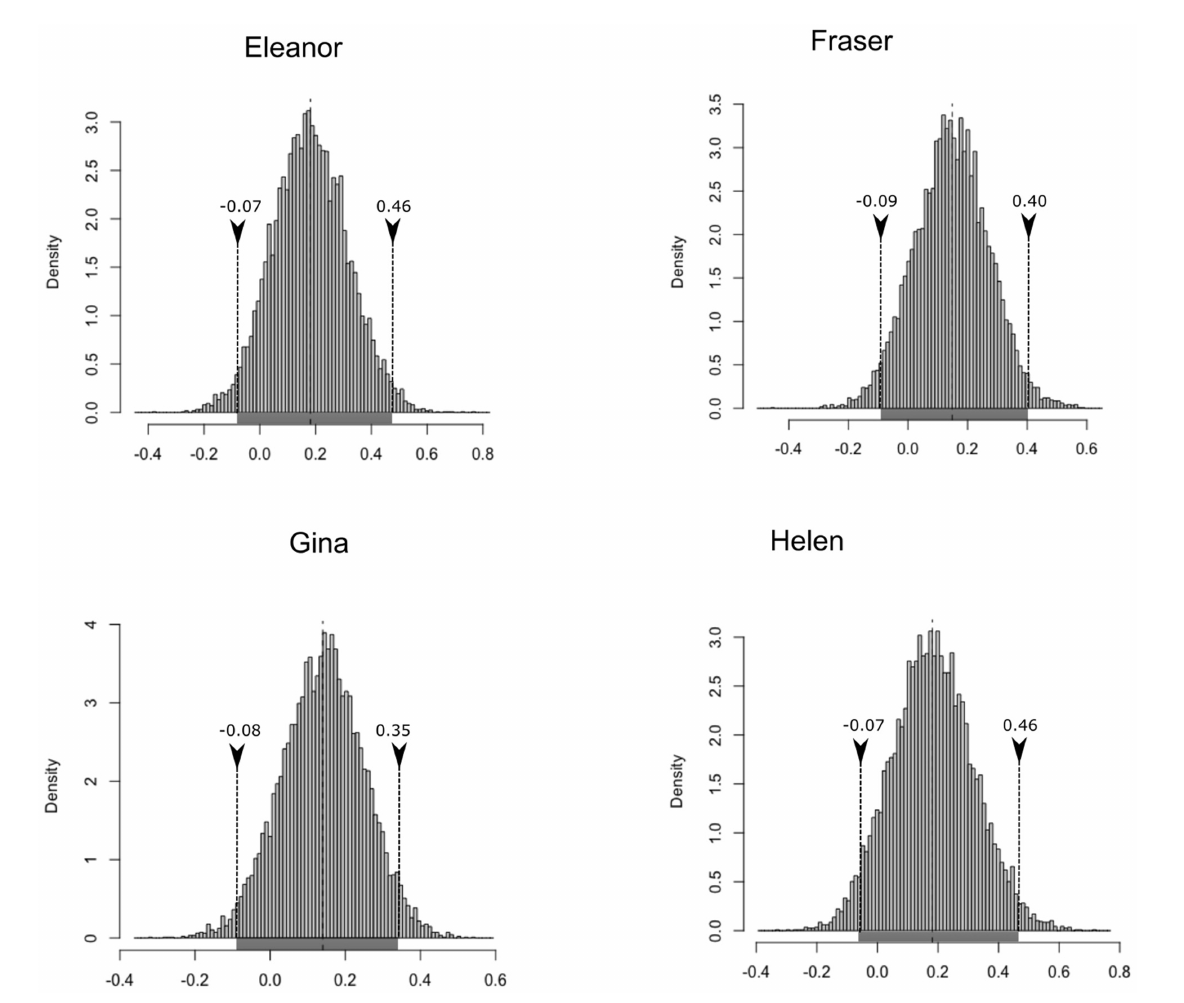
FIGURE 5 Histogram of the bootstrapped replicates of the differences in inflections per verb at Time 2 and Time 1 in the four English speaking